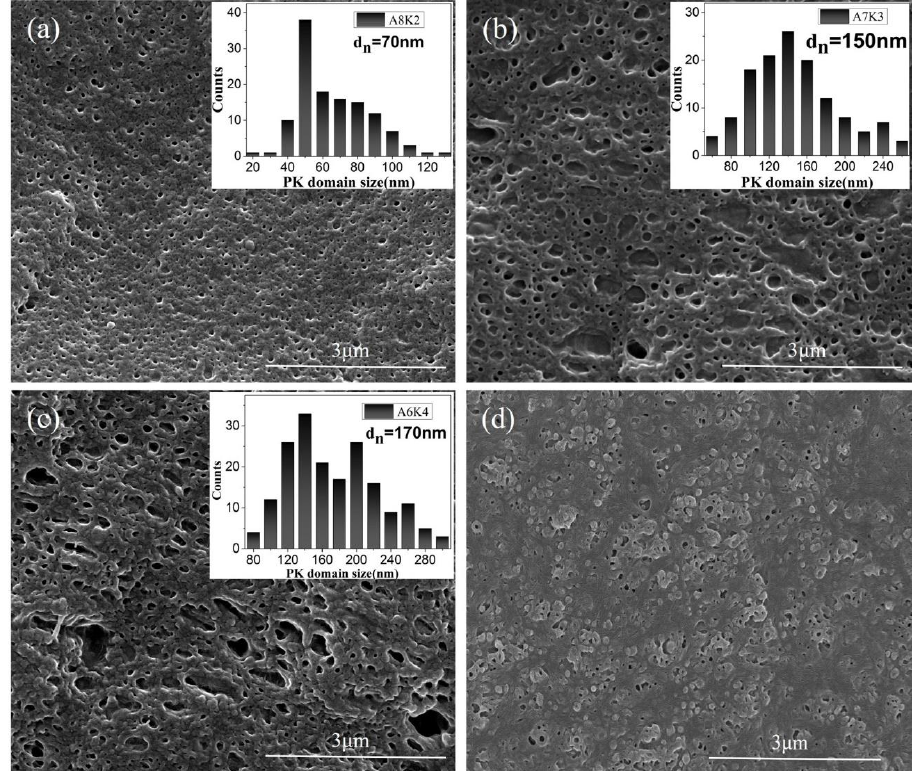
Scanning electron microscope (SEM) images of nanostructured polyamide 12 Figure 1. SEM images of nanostructured polyamide 12 (PA12)/polyketone(PK) blends and corresponding distribution of PK domain size as insets. ( a ) A8K2; ( b ) A7K3; ( c ) A6K4; and ( d ) A5K5. (PA12)/polyketone (PK) blends, with the corresponding distribution of PK domain size shown in insets. ( a ) A8K2; ( b ) A7K3; ( c ) A6K4; ( d )